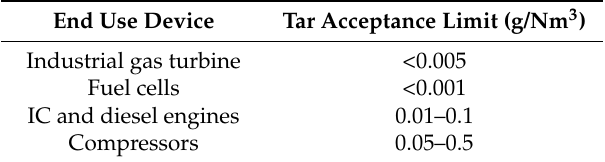
Table 1. Tar acceptance limit for different devices. IC: internal